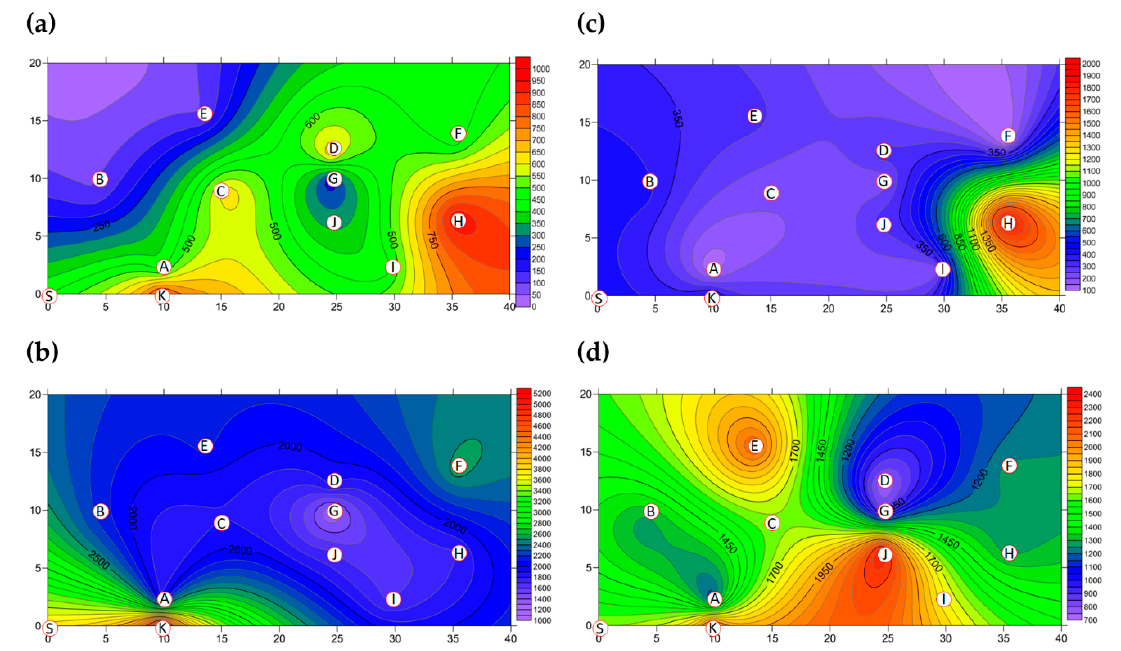
Figure 8. The FBs (CFU m − 3 ) present as ( a ) LPBs and ( b ) SPBs present in Market B before operations commenced and ( c ) LPBs ( d ) SPBs present after operations had finished. Red circular dots with English titles represent the sampling locations.